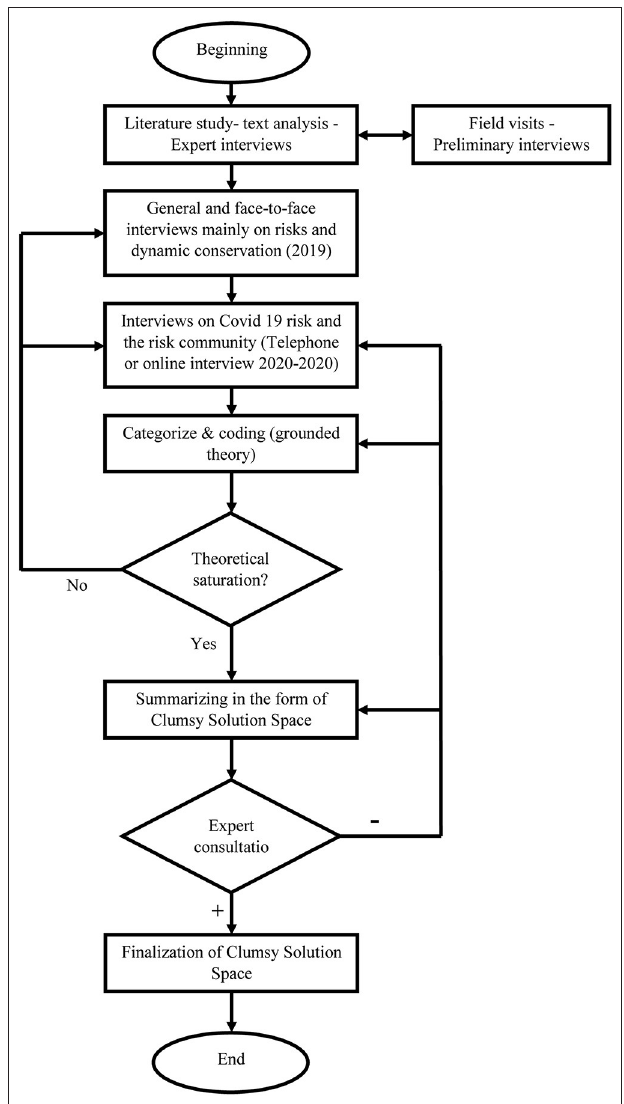
FIGURE 4 | Research steps and